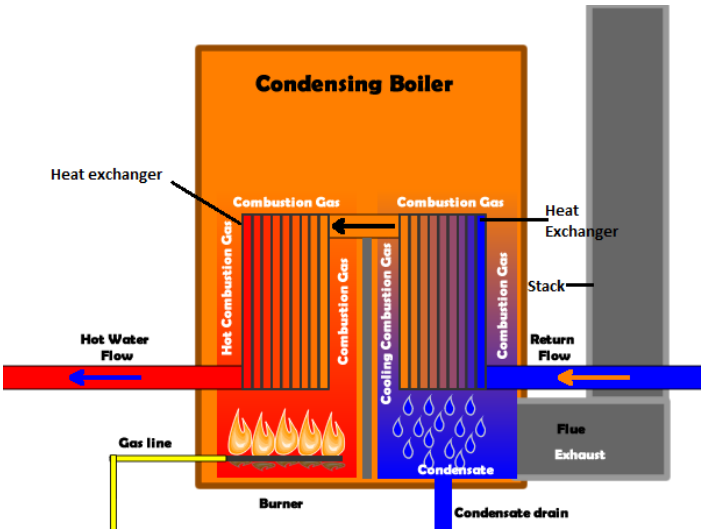
Figure 1. Condensing